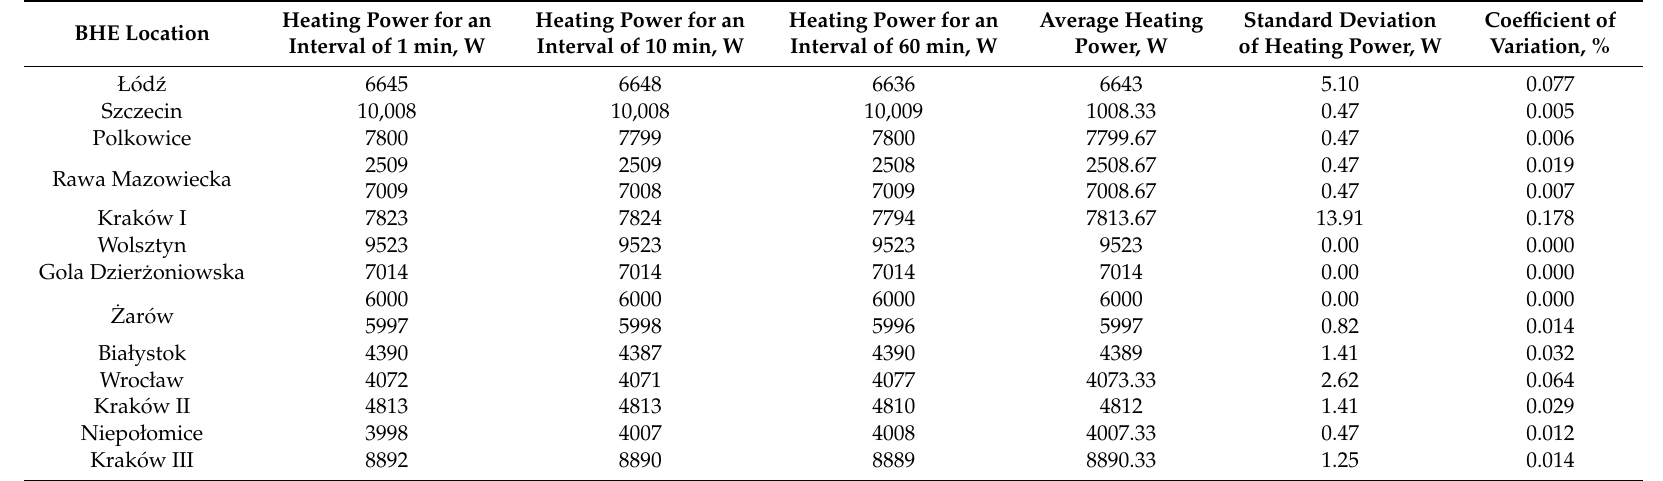
Table 8. Summary of the heating power of borehole exchangers for which a thermal reaction test was